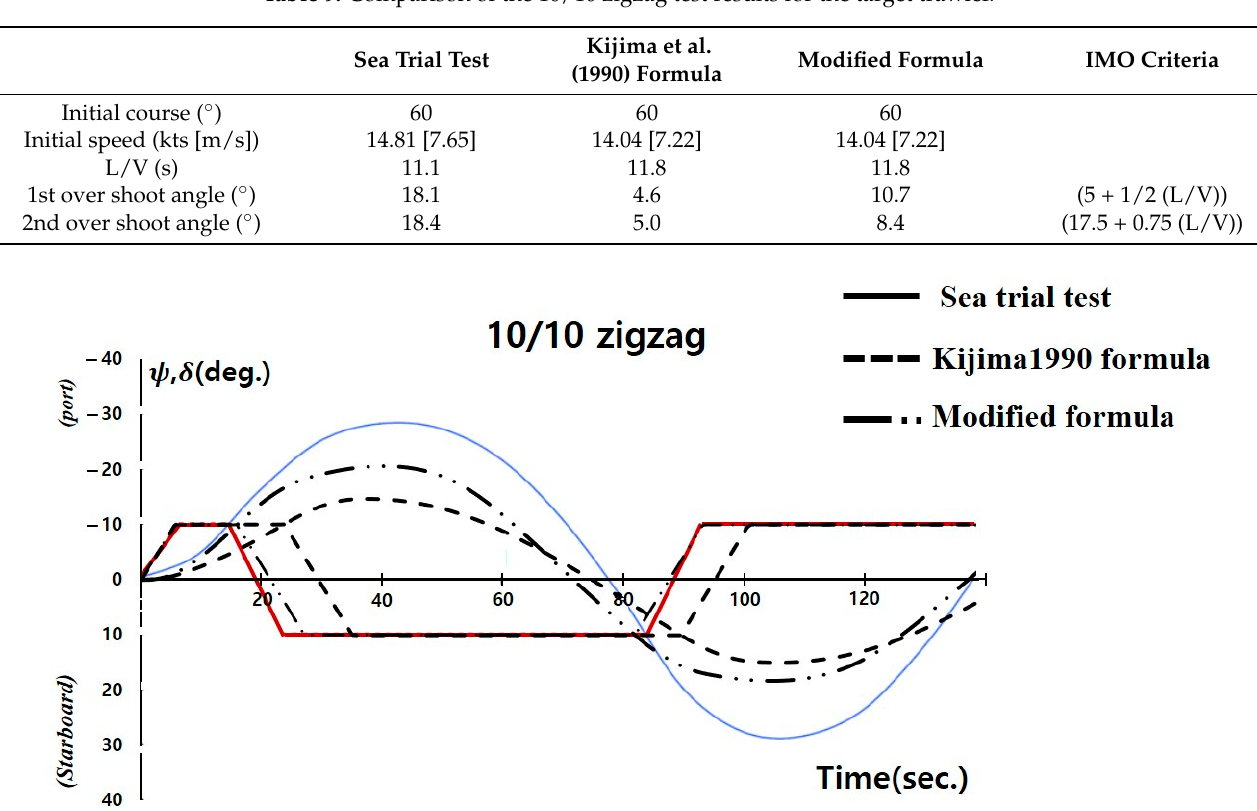
Figure 9. Comparison of the 10/10 zigzag test results for the target trawler.